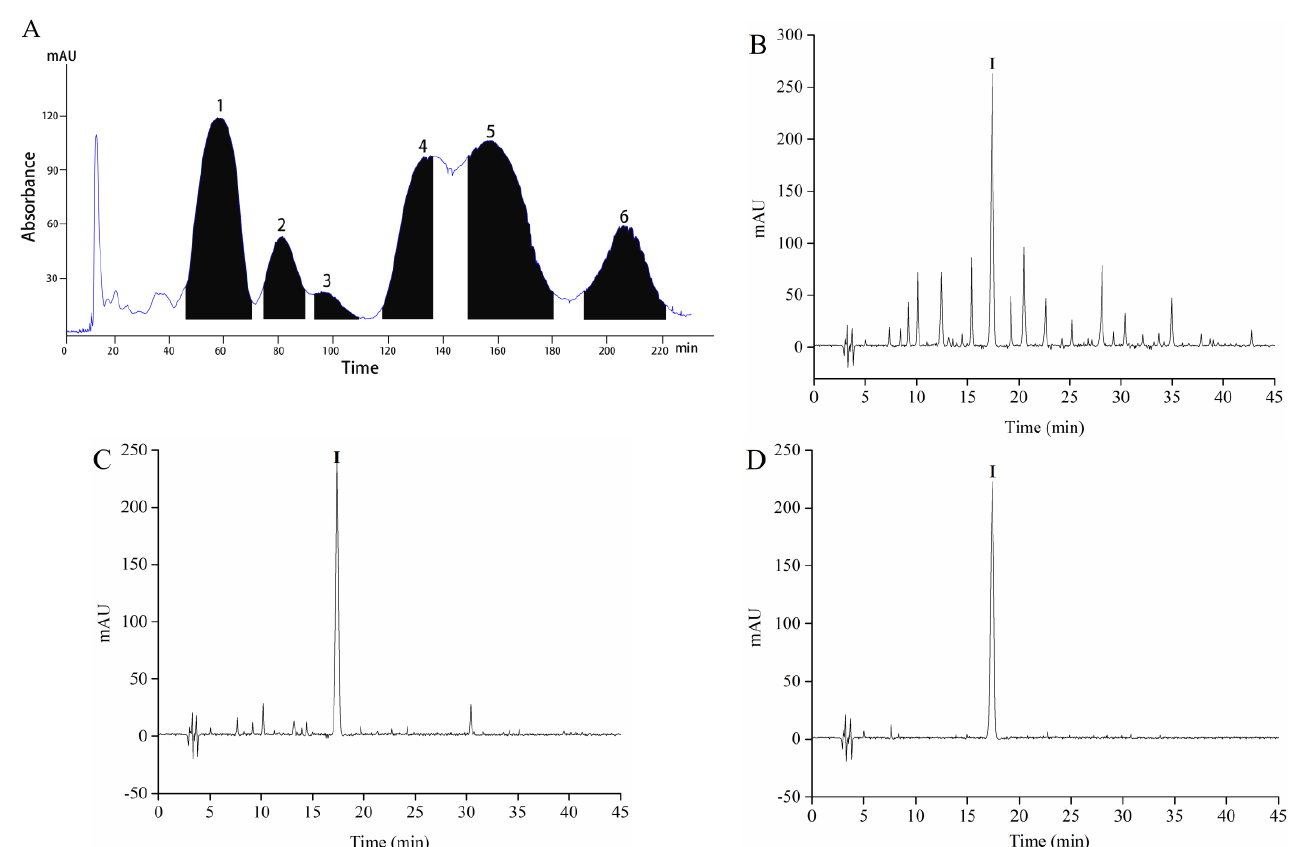
Figure 2. The High-speed counter-current chromatography (HSCCC) chromatogram of fractionation of Sample 4 ( A ), HPLC chromatograms of Sample 4 ( B ), F4 ( C ), and component I ( D ). Table 1. Identify of the component I using